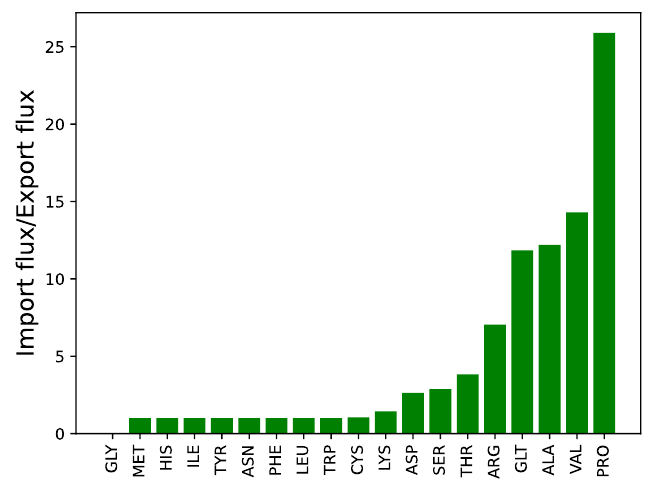
Figure 1. Ratio of flux in amino acid uptake transporters to their respective biomass exporters. Import flux of isoleucine, leucine, phenylalanine, tryptophan, tyrosine, asparagine, histidine and methionine is equal to the export of their respective biomass components. While the uptake flux for the remaining amino acids except glycine is higher than that in respective biomass exporters. There is no uptake of glycine from the medium and the demand for glycine in the biomass is met internally.